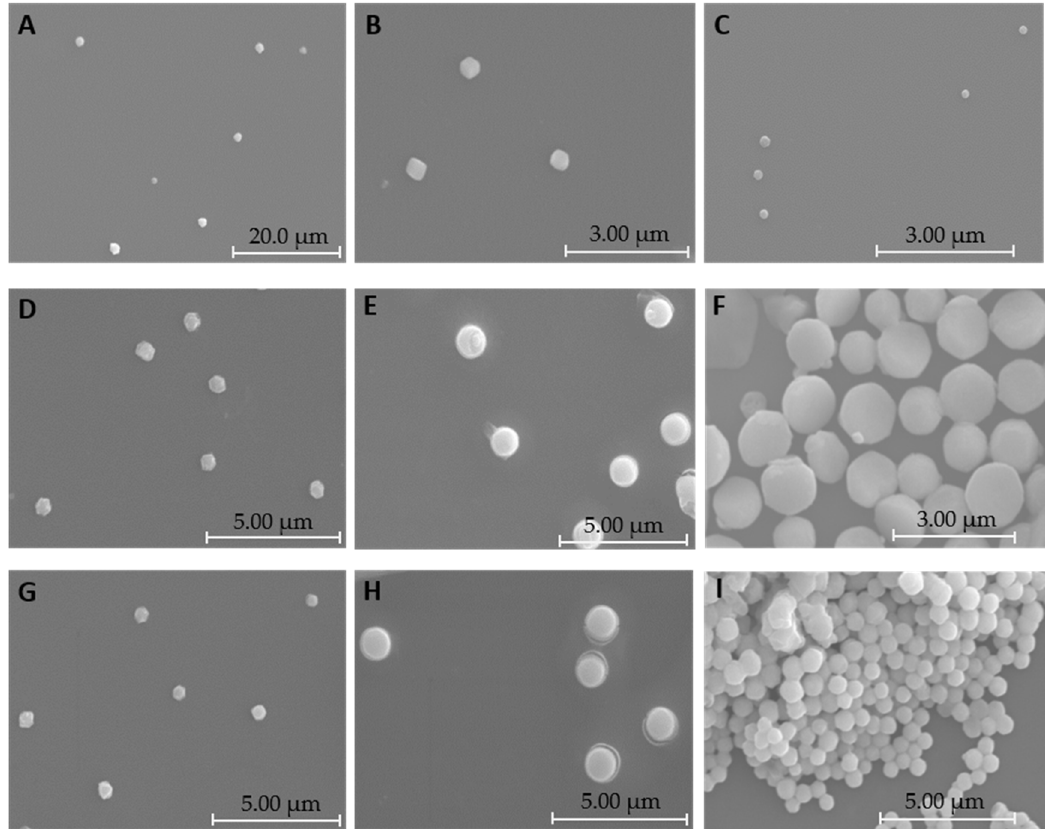
Figure 4. Scanning electron micrographs of particles formulated at the ( A ) R8-mannose/mcDNA N/P ratio of 1:1; ( B ) R8-mannose/mcDNA N/P ratio of 1.5:1; ( C ) R8-mannose/mcDNA N/P ratio of 2:1; ( D ) R8-mannose/PEI/mcDNA N/P ratio of 1:5:1; ( E ) R8-mannose/PEI/mcDNA N/P ratio of 1.5:5:1; ( F ) R8-mannose/PEI/mcDNA N/P ratio of 2:5:1; ( G ) R8-mannose/PEI/mcDNA N/P ratio of 1:10:1; ( H ) R8-mannose/PEI/mcDNA N/P ratio of 1.5:10:1; and ( I ) R8-mannose/PEI/mcDNA N/P ratio of 2:10:1.